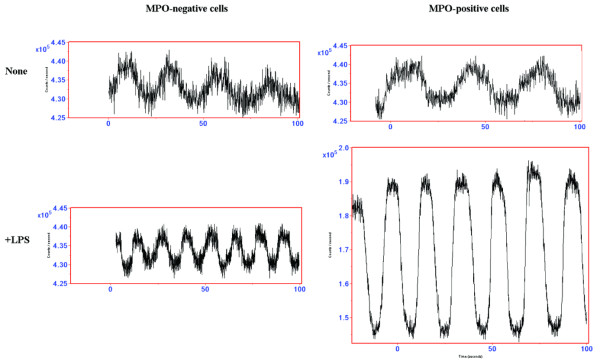
Representative kinetic traces illustrating the JRA-associated abnormality in metabolic oscillations of neutrophils. These traces show NAD(P)H autofluorescence intensity (ordinate) versus time (abscissa); to conserve space, only a few oscillations are shown. Polarised cells were studied on glass slides at 37°C. Using an anti-MPO antibody in immunofluorescence microscopy, JRA neutrophils can be classified as MPO-negative (left) and MPO-positive (right). Untreated MPO-negative cells demonstrated NAD(P)H oscillations with a period of approximately 20 seconds (trace a). The NAD(P)H oscillatory period of these cells decreased to 10 seconds in the presence of the activator LPS. In patients with JRA, a subpopulation of neutrophils are MPO-positive. In the absence of cell stimulation, MPO-positive cells cannot be distinguished from MPO-negative cells. However, in contrast to MPO-negative cells, MPO-positive cells undergo both a decrease in period to 10 seconds and a dramatic increase in the oscillatory amplitude. JDA, juvenile rheumatoid arthritis; LPS, lipopolysaccharide; MPO, myeloperoxidase; NAD(P)H, nicotinamide adenine dinucleotide (phosphate).